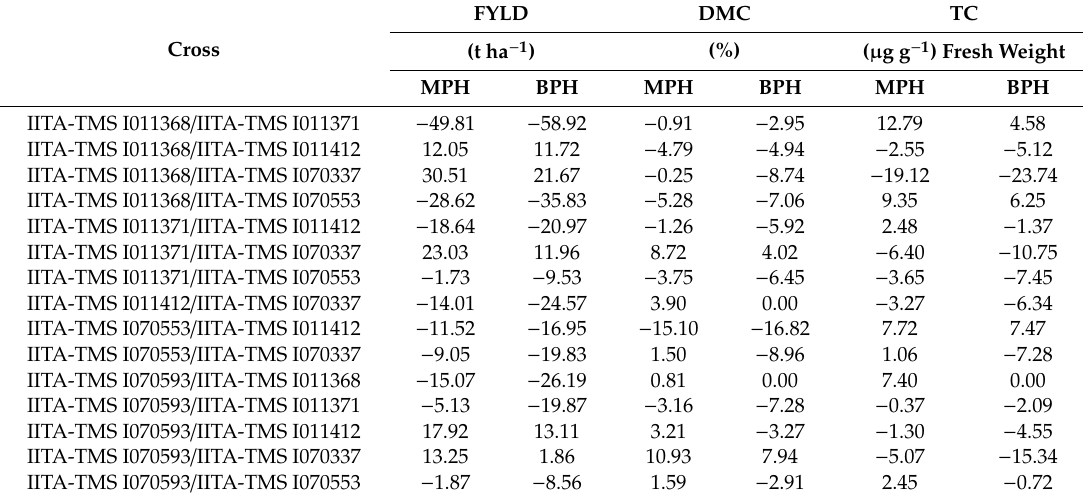
Table 7. Heterosis (%) relative to mid parents (MPH) and better parents (BPH) for studied characteristics. FYLD DMC TC Cross (t ha − 1 )